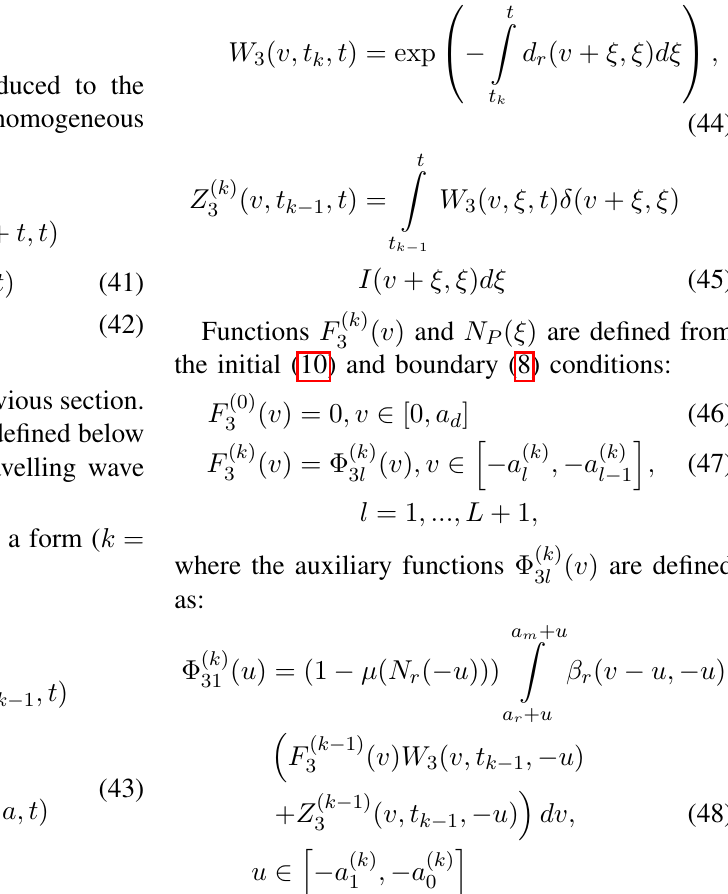
( v ) , l = 1 , ..., L + 1 , L = 4 1 l